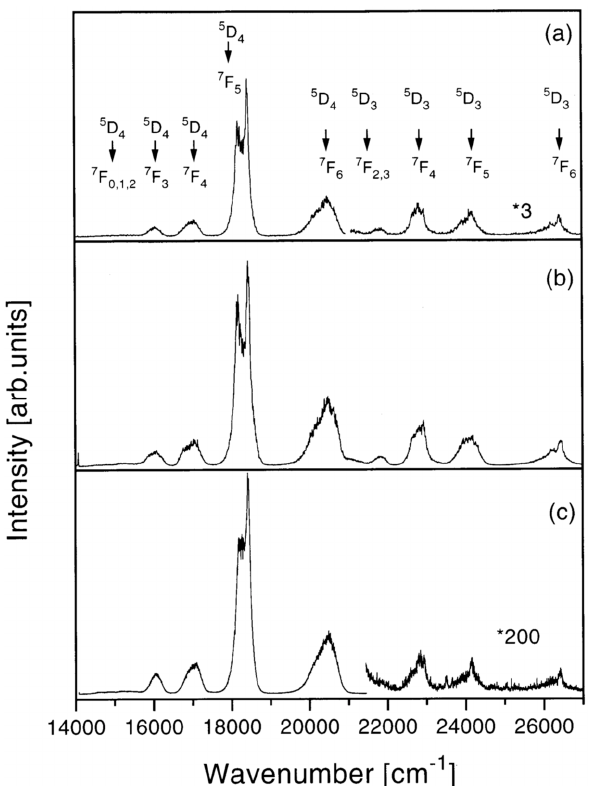
Figure 4. Room-temperature luminescence spectra after excitation at 355 nm of the silica xerogel samples: ( a ) 200 ppm (900 °C, 120 h); the right end of the spectrum is magni fi ed 3 times (*3), ( b ) 400 samples: ( a ) 200 ppm (900 ◦ C, 120 h); the right end of the spectrum is magnified 3 times (*3), ppm (900 °C, 72 h), and ( c ) 10,000 ppm (900 °C, 120 h) Tb:Si; the right part of the spectrum is mag- ni fi ed 200 times (*200). Reproduced with permission from [36], copyright 1998, Elsevier. ( b ) 400 ppm (900 ◦ C, 72 h), and ( c ) 10,000 ppm (900 ◦ C, 120 h) Tb:Si; the right part of the spectrum is magnified 200 times (*200). Reproduced with permission from [36], copyright 1998,